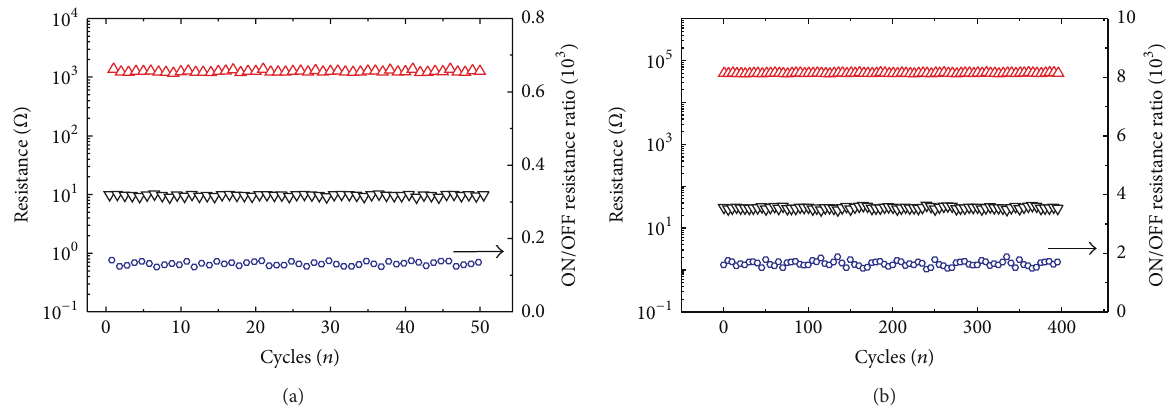
Figure 3: The reversible resistance switching behavior and ON/OFF resistance ratio for (a) Pt/TiO 2 /Pt and (b) Pt/TiO 2 /LAO/Pt. The read voltage is set at 0.1V. The set and reset voltage are 5.0 and 2.0 V.